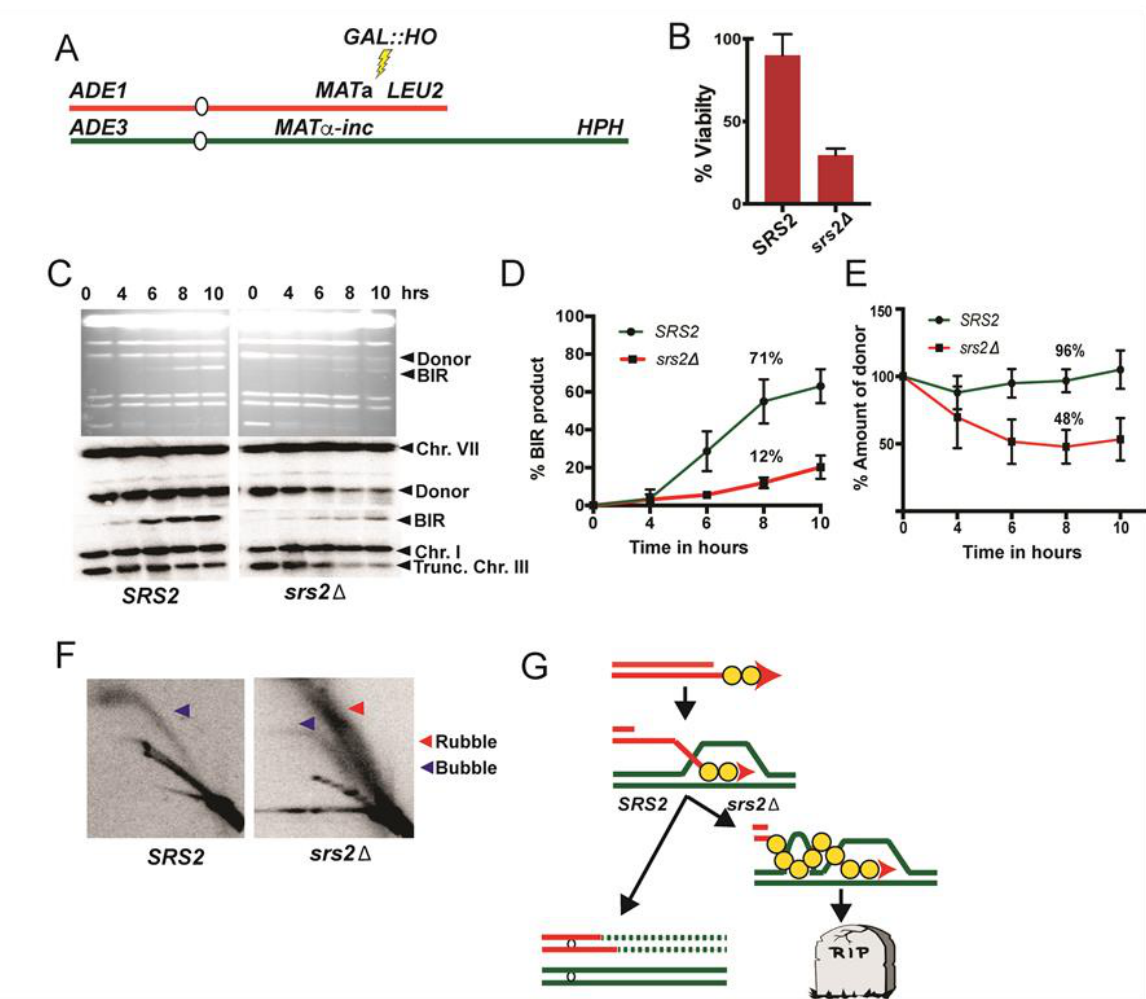
FIGURE 12: Detection of toxic recombination intermediates during BIR in yeast. (from data in Elango et al [214] published under open access under a Creative Commons Attribution 4.0 International License) (A) Experimental system to study BIR. BIR is initiated by DSB in- troduced by galactose-induced HO endonuclease at MAT a locus in yeast disomic for Chr. III (B) Cell viability following DSB induction (%). (C) BIR kinetics analyzed by CHEF gel using cells taken at indicated time points following DSB induction. Upper panel: CHEF gels stained with Ethidium Bromide. Subsequent panels below show Southern blot analysis using ADE1 -specific, and ADE3 -specific probes, hybridizing to the recipient and the donor chromosomes, respectively. (D) Quantification of BIR product. (E) Quantification of donor chromosome entering the gel. (F) 2D gel analysis of BIR intermediates in SRS2 and srs2 Δ at 7h following DSB induction. Genomic DNA was digested with BglII to detect intermediates at 24 kb position. Intermediates were detected using a probe specific to the 24 kb position of Chr III. Blue arrowheads denote bubble arc intermediates and red arrowhead denotes ‘rubble’ structure. (G) The schematics shows broken recipient chromosome (red) invading unbroken homologous donor (green). Repair DNA synthesis is initiated and progresses by a migrating bubble. In SRS2: successful completion of BIR with conservative inheritance of newly synthesized DNA. In srs2  : formation of toxic joint mole- cules via unscheduled invasion of ssDNA located behind the BIR bubble into homologous chromosome leading to cell